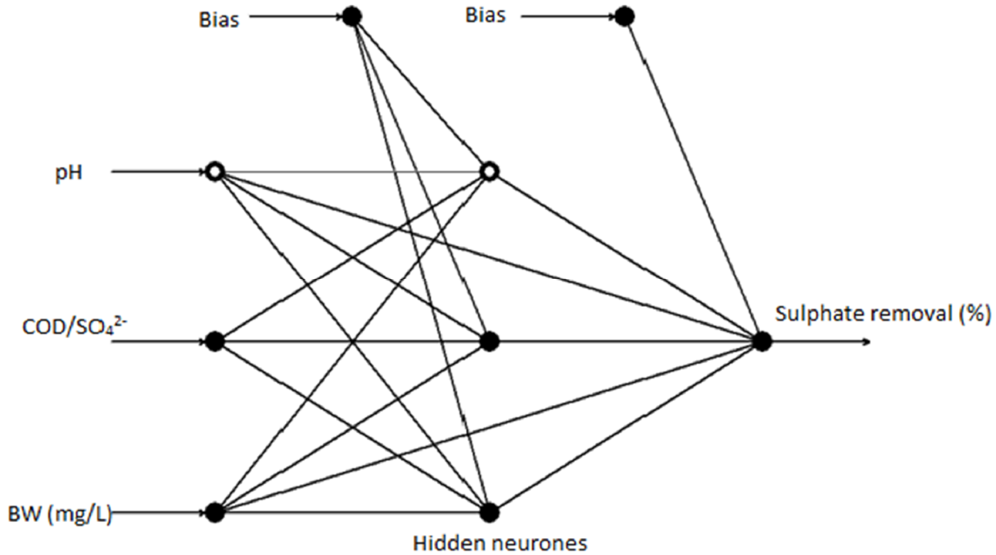
Figure 1. Artificial neural network (ANN) architecture for the estimation of sulphate reduction in the treatment of acid mine drainage (AMD) using brewing wastewater (BW) as carbon source. treatment of acid mine drainage (AMD) using brewing wastewater (BW) as carbon